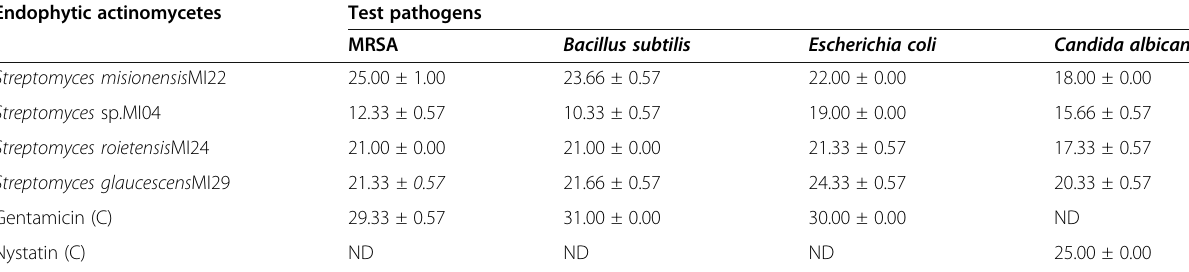
Table 2 Determination of anti-microbial activity of ethyl acetate extract of endophytic Streptomyces strains against test microbial pathogens